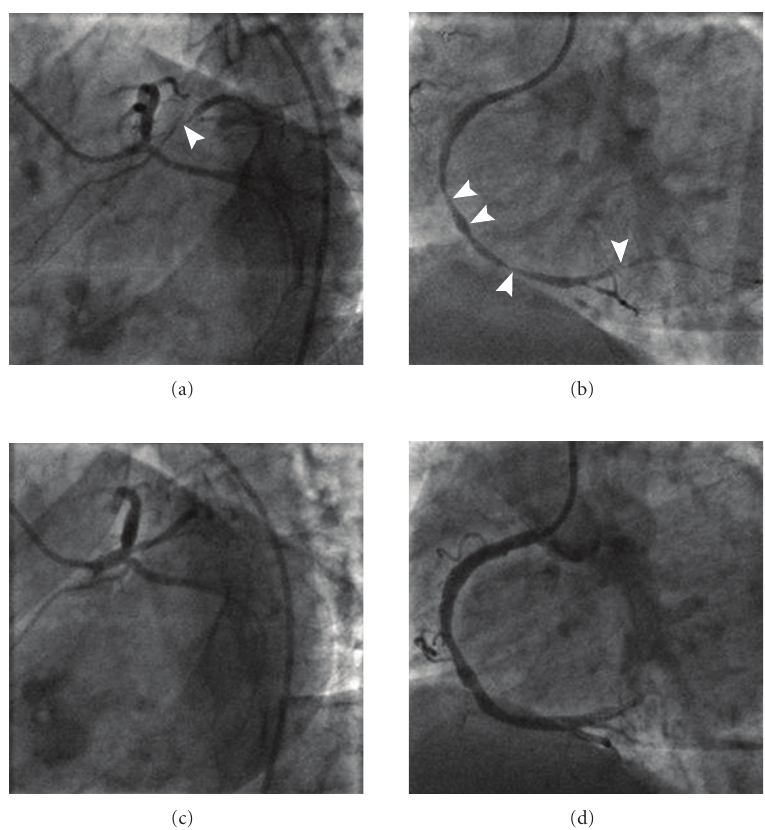
Figure 2: Selective Coronary Angiographic Images. Apparent stenoses in (a) intermediate and (b) right coronary arteries. Subsequent attenuation of lesions in the (c) intermediate and (d) right coronary arteries following administration of intra-coronary